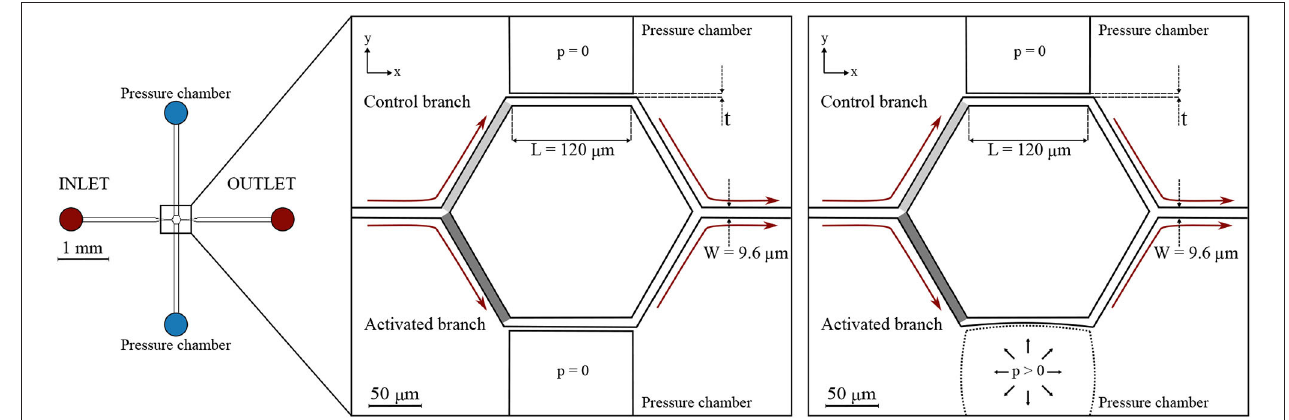
FIGURE 1 | Single-mesh network. Schematic of the microfluidic device (left) and magnified images (right) with a passive ( p Regions of interest are marked in light gray and dark gray for the control branch and the activated branch, respectively. The device had a single inlet and a single outlet and embedded a single hexagonal mesh with two pressure chambers on the sides. All micro-channels had a width W L 120 µ m . Two designs with different membrane thickness were used: t 1 = plane of the microscope, whereas Z is in the perpendicular direction.